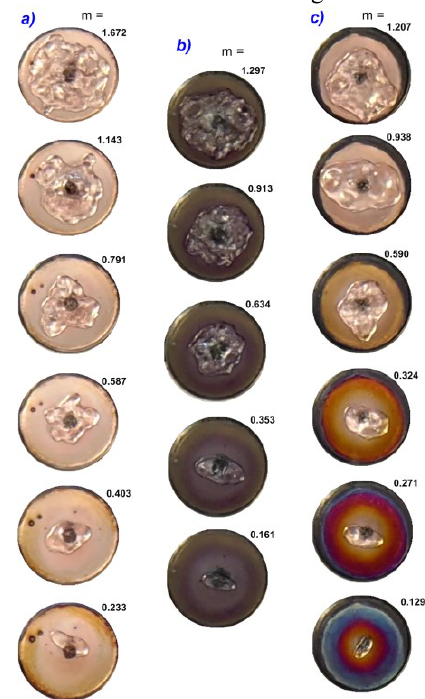
Fig. 5. Forms of droplets: a) ethanol, b) phthalic petrol, c) 25% ethanol in phthalic